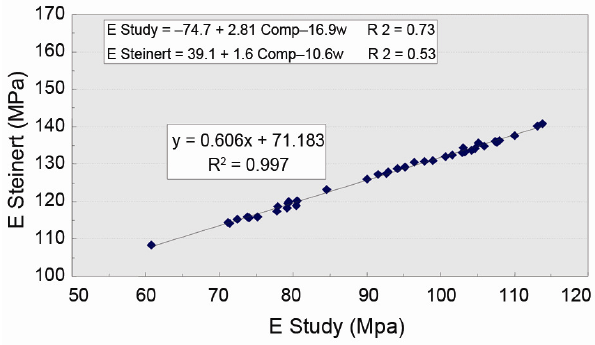
Fig. 8. Comparison between current study model to Steinert